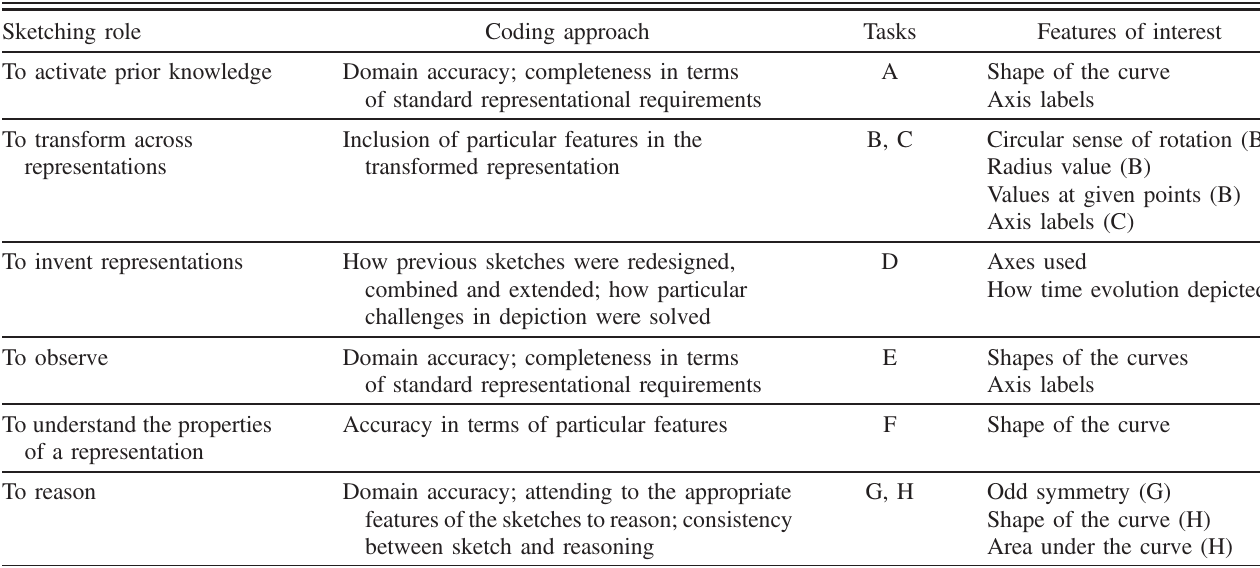
TABLE I. The two left-hand columns give an overview of the approaches used to code students ’ responses that were developed to align with the intended roles of sketching. The two right-hand columns show how these approaches were operationalized in terms of features of interest for the specific sketching tasks from Figs. 3 and 4. More details on these features are given in Secs. V B and V C. Sketching